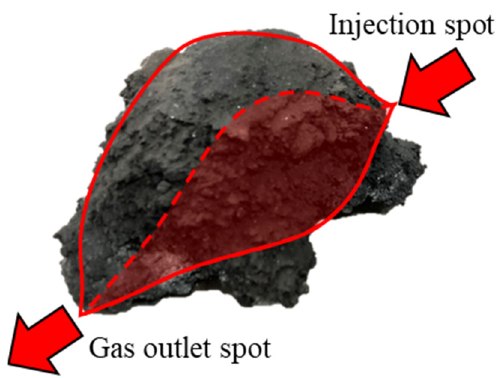
Figure 6. Final shape of gasification cavity (expanding foam).